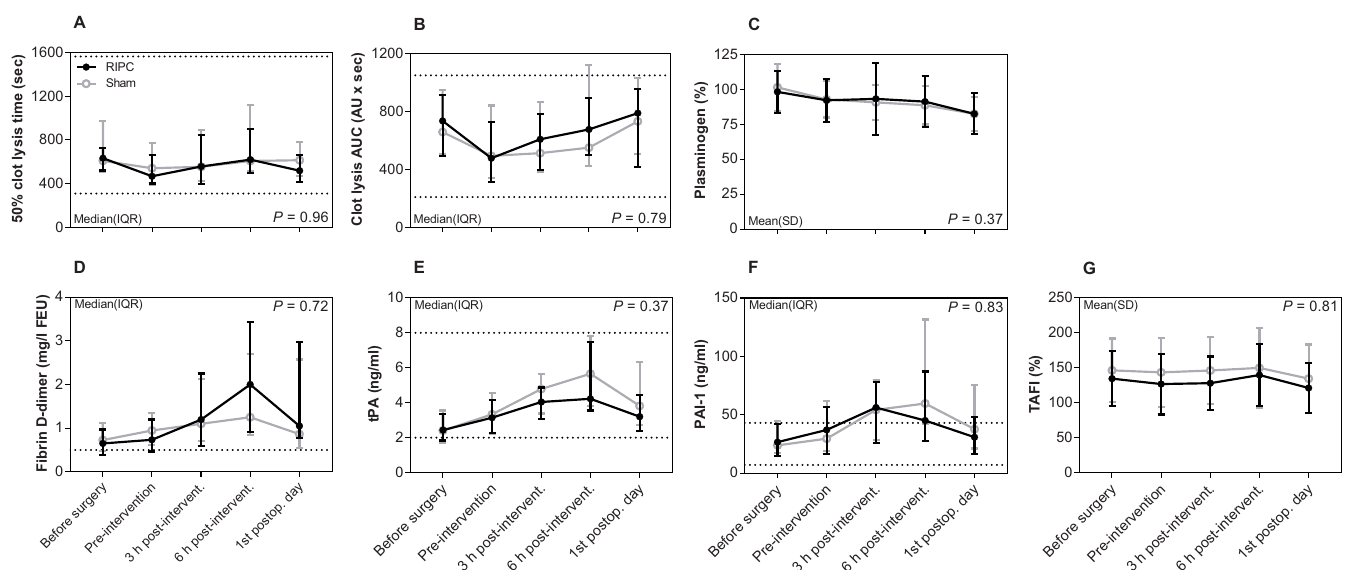
Fig 3. Fibrin clot lysis assay and fibrinolysis biomarkers. Data are shown as mean ± SD or median with IQR. Lines indicate common reference intervals for healthy men and women from our laboratory if available. Reference intervals for tPA and PAI-1 were provided by the manufacturer. P -values represent the multivariate repeated measures ANOVA. Mixed-model was used for fibrin clot lysis data. Missing data: Fibrin clot lysis produced flat curves in 18 samples obtained pre-intervention (8 RIPC, 10 sham), 5 samples obtained 3 h post-intervention (3 RIPC, 2 sham), and 14 samples obtained on the first postoperative day (7 RIPC, 7 sham). Fibrin clot lysis curves did not lyse in 4 samples obtained 3 h post-intervention (2 RIPC, 2 sham) and 6 samples obtained 6 h post-intervention (3 RIPC, 3 sham). Abbreviations: PAI-1: plasminogen activator inhibitor-1, RIPC: remote ischemic preconditioning, TAFI: thrombin activatable fibrinolysis inhibitor, tPA: tissue-type plasminogen activator.